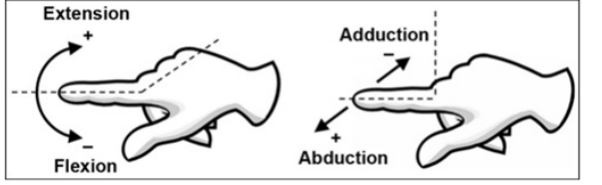
Figure 2: Motions of thumb and fingers.